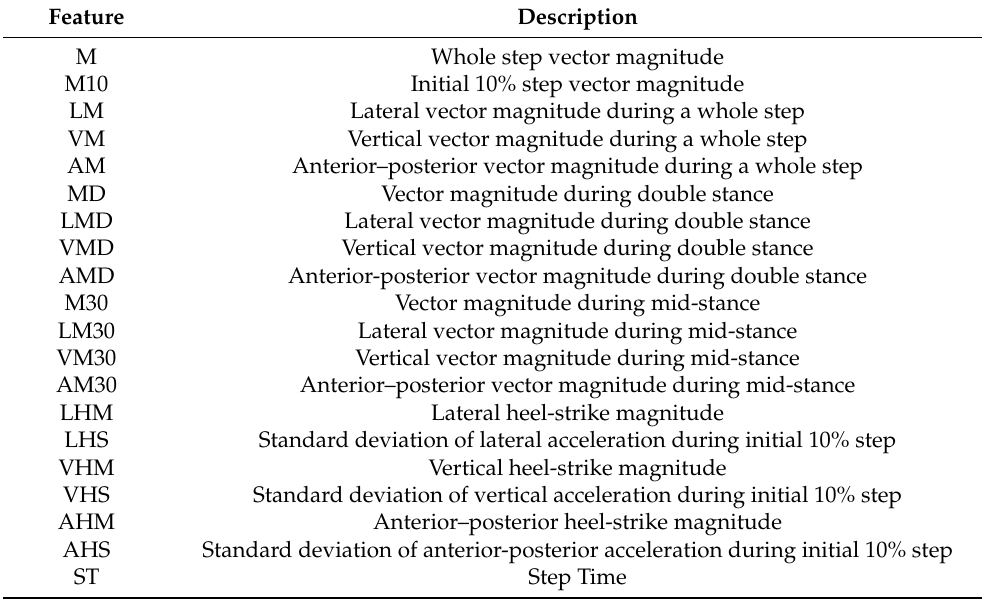
Table 2. Description of extracted